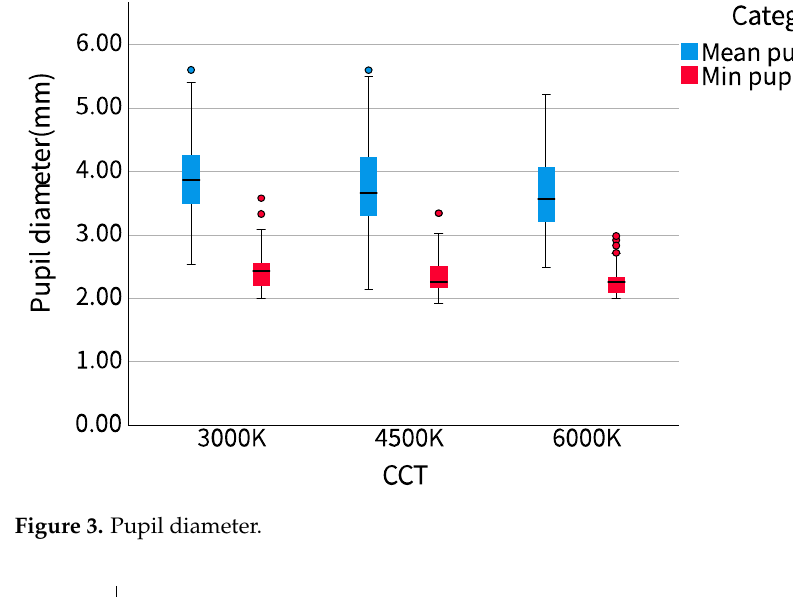
Figure 3. Pupil diameter.